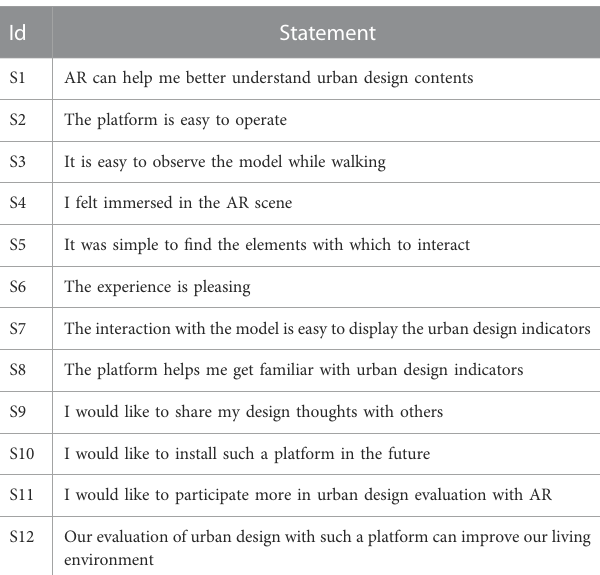
TABLE 1 The twelve statements on Questionnaire B.